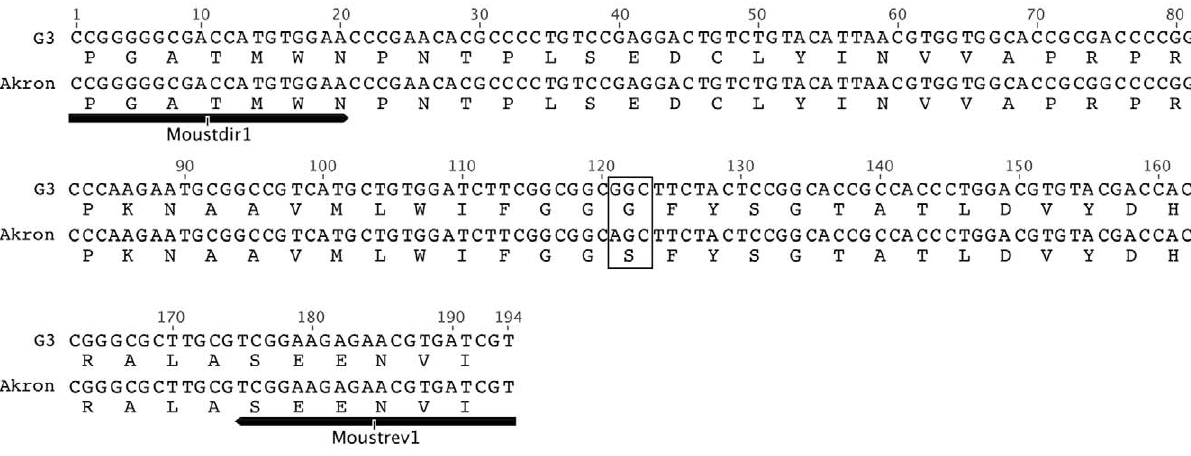
Figure 2. Nucleotide and deduced amino acid sequences of the ace - 1 amplicons of susceptible (G3) and resistant (Akron) An. gambiae . The alignment of DNA sequences illustrates the presence of the AG|CT Alu I restriction site in the Akron ace - 1 amplicon (194 bp) spanning the 119 (G/S) and 120 (F) codons of the Ag AChE-1 amino acid sequence; the 119 codon is marked with a rectangle. The arrows indicate the position of the degenerate primers (Moustdir1 and Moustrev1) used for the PCR amplification and sequencing of genomic DNA. Nucleotide numbers in the amplicon are provided above the G3 sequence.